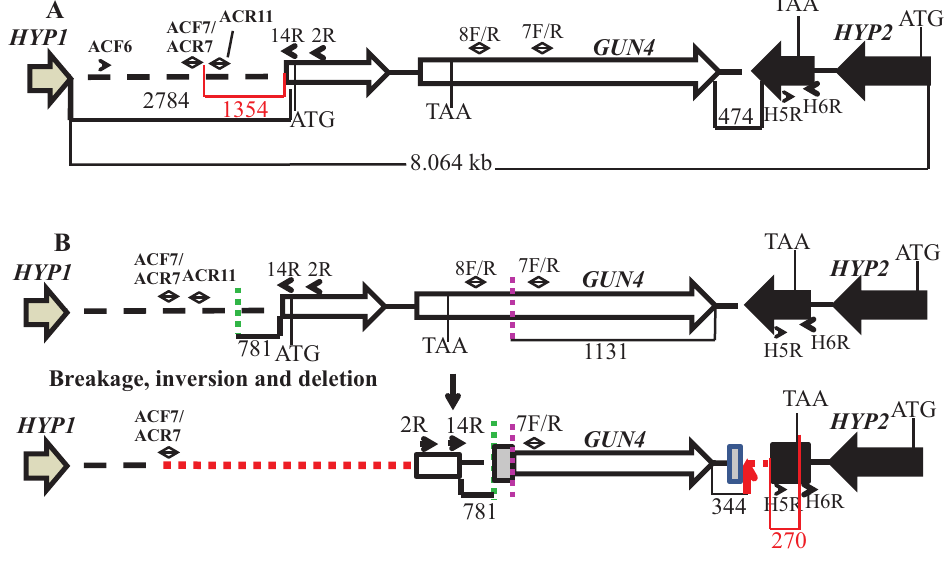
Figure 6. A schematic of the genetic rearrangement in 6F14 . ( A ) A schematic genomic map showing an 8.064 kb genomic DNA region spanning the GUN4 locus on chromosome 5. The numbers at the bottom of the map denote distances between respective points on the genomic DNA. The red highlighted region and number show the distance between primer ACF7 and the start of the GUN4 gene and the distance between the primer H5F and the end of the HYP2 gene, respectively. The two GUN4 exons are represented by white block arrows. The tan arrow and the black block arrow, denotes a part of HYP1 3 ′ UTR and HYP2 gene, respectively. ( B ) An updated schematic diagram showing the rearrangement of the GUN4 locus based on PCR analyses and DNA sequencing. Two break points in the genome are denoted by green and pink dashed lines. The big and the small grey boxes, denote addition of 45 and 29 bp, respectively. The small black arrows denote primers that were used for genomic PCRs in Figure S4 and Figure S5. Red dashed lines denote possible deletions. The small red arrow indicates the point of insertion of the pBC1 plasmid. The black numbers at the bottom of the map denote distances between respective points on the genomic DNA. The red highlighted region and the corresponding number show the distance between the end of the primer H5F and the stop codon of the HYP2